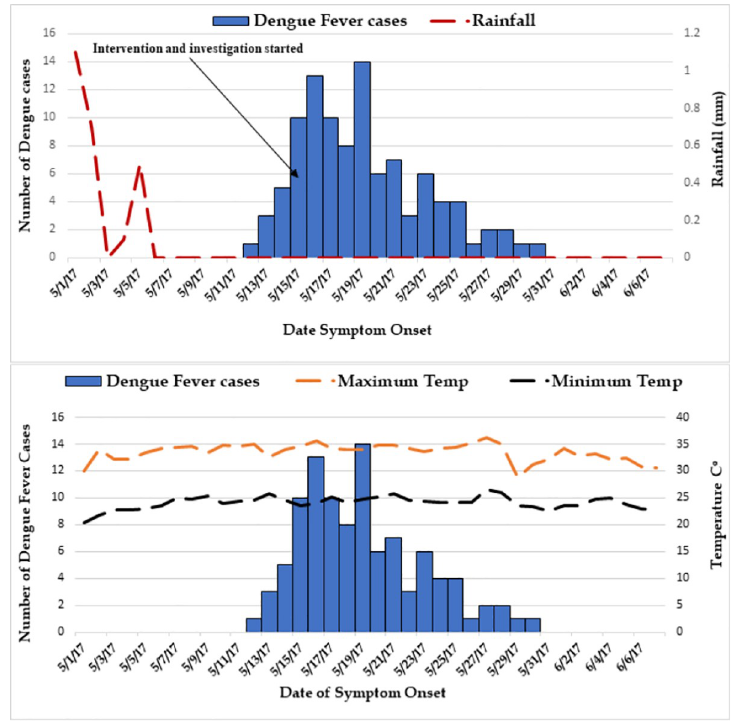
Fig 1. Daily Dengue Fever Cases and Climatic Factors–Kabridahar District, Korahay Zone, Somali region, Ethiopia, May to June, 2017.